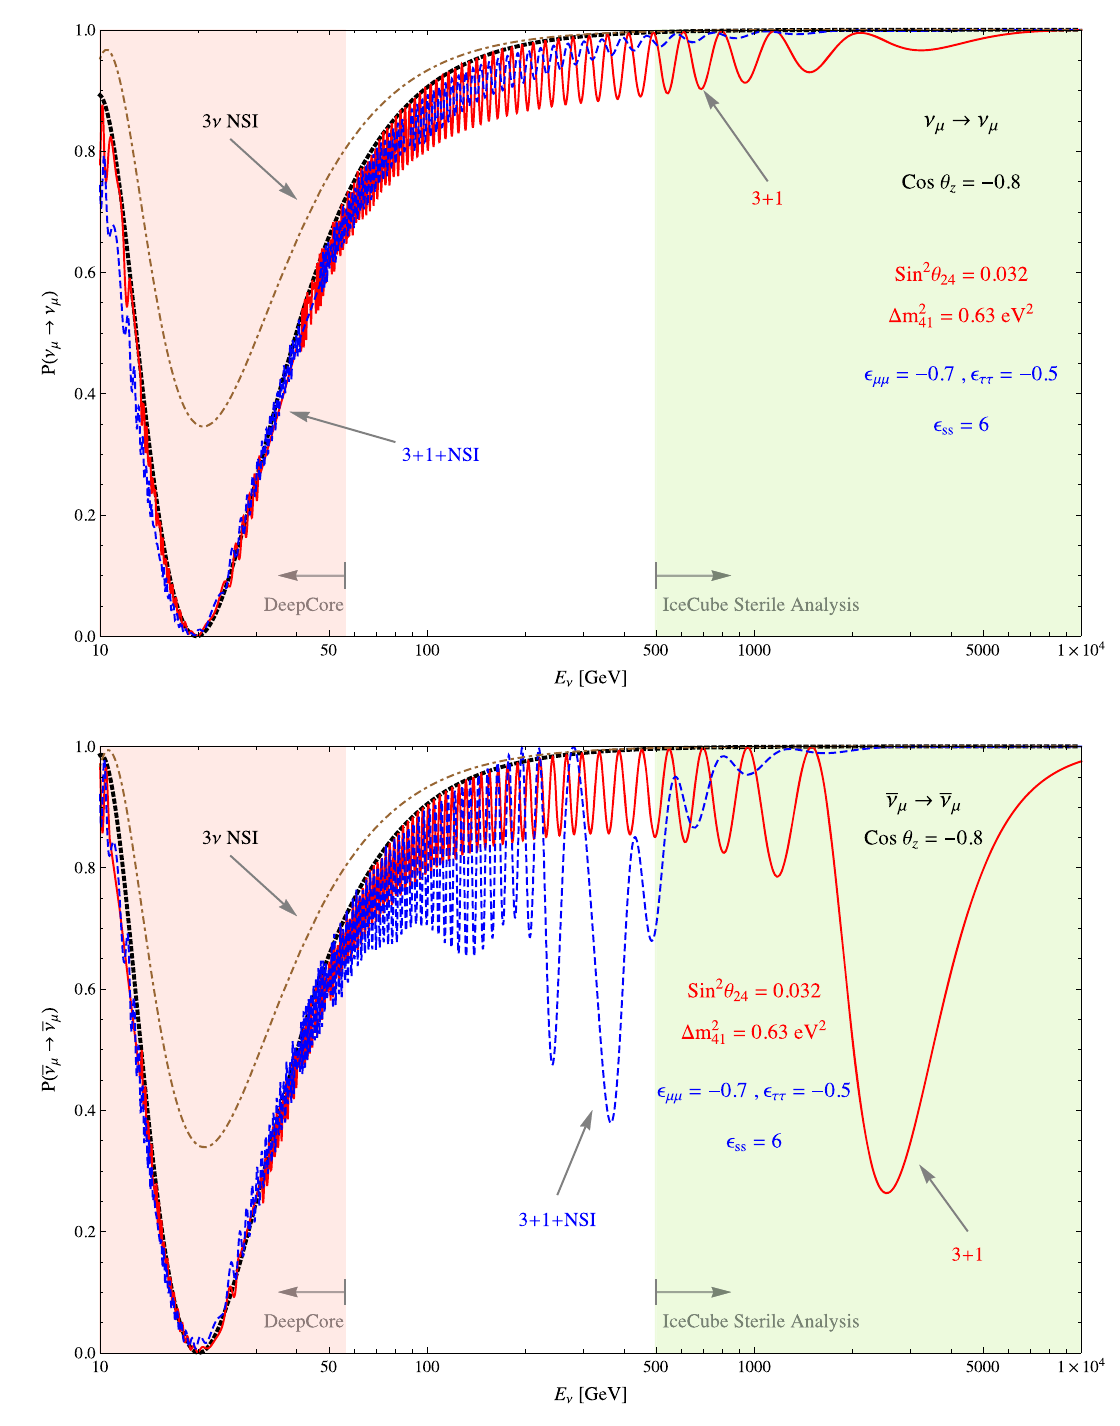
where α and β are the pull parameters taking into account the correlated uncertainties of the atmospheric neutrino flux normalization and its zenith dependence (tilt), respectively. Using the Honda flux of atmospheric neutrinos [34], these uncertainties are roughly σ α = 0 . 24 and σ β = 0 . 04.